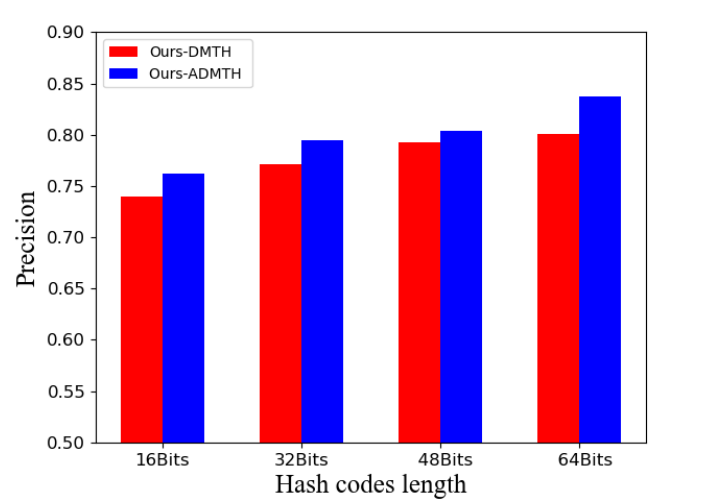
Figure 4. Attention mechanism ablation experiment on